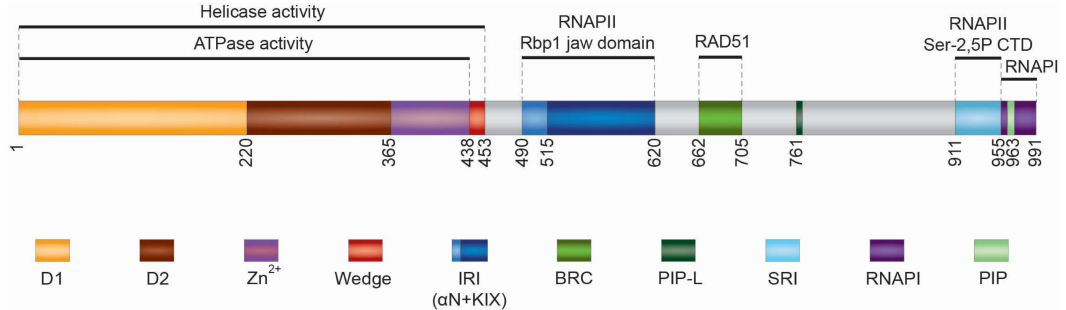
Figure 1. Domain organization of human RECQ5 helicase. For description of the individual domains see the main text. The positions of amino acids at domain boundaries are